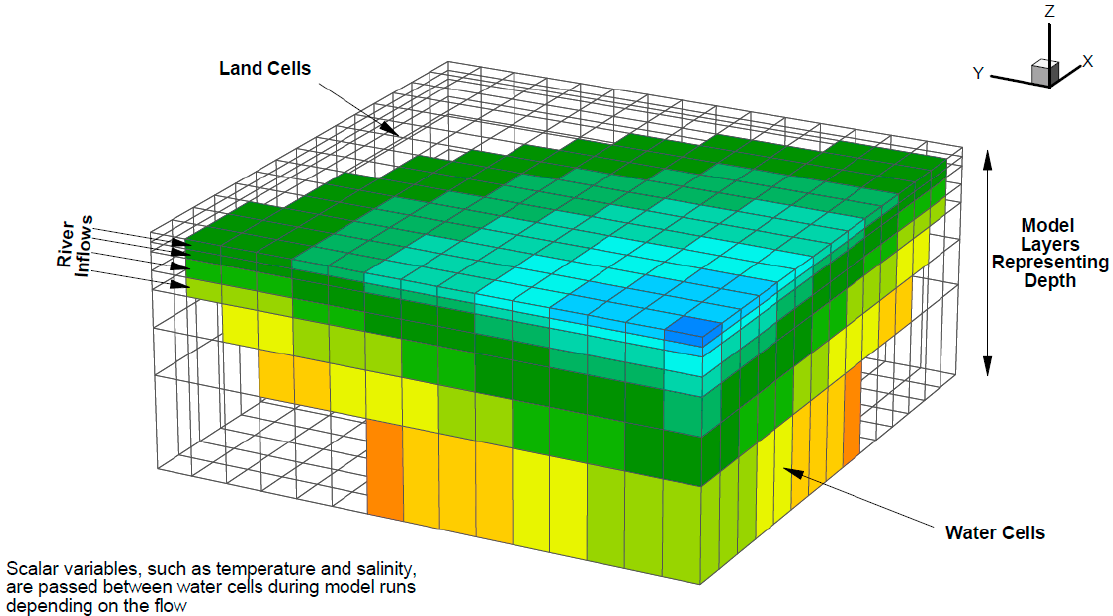
Figure 2. Typical grid mesh used in H3D.